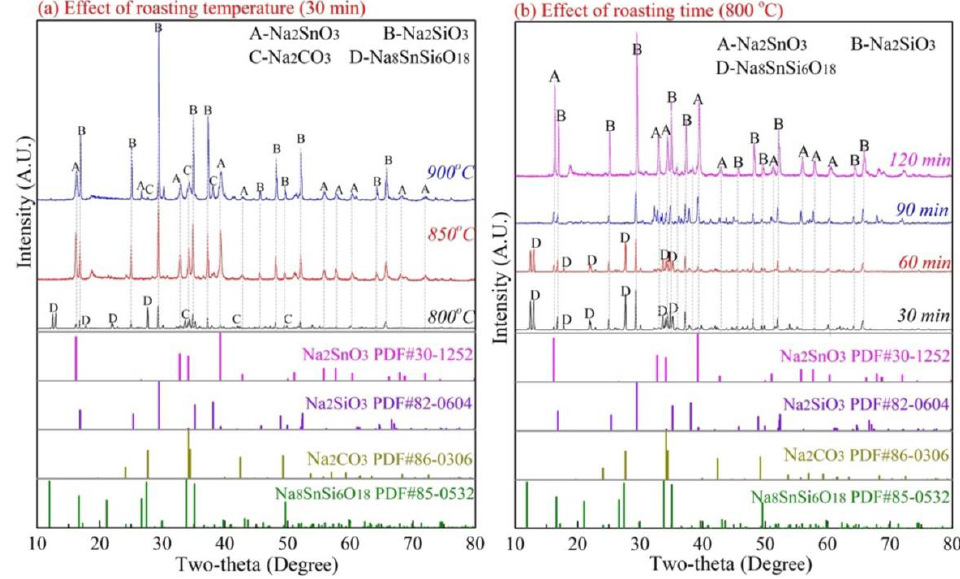
Figure 11. Effect of roasting temperature and time on the reaction between Na 8 SnSi 6 O 18 and Na 2 CO 3 .